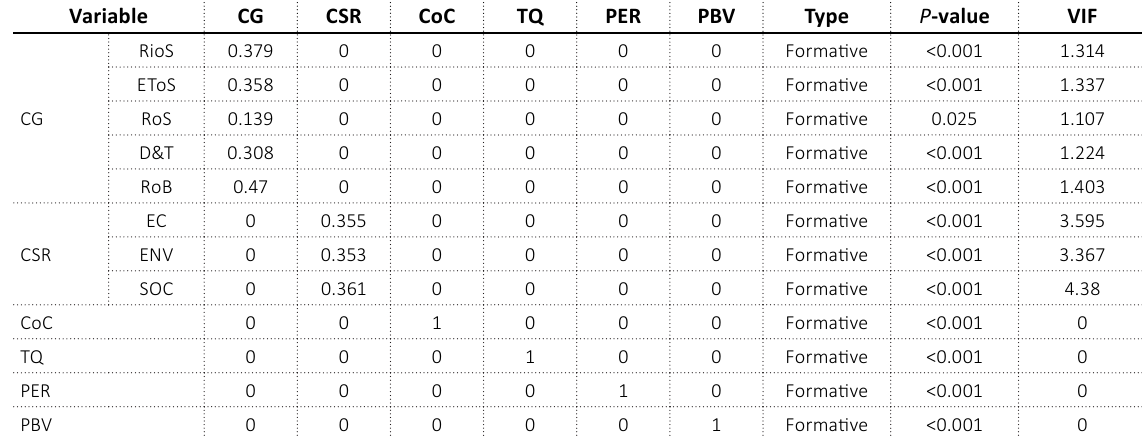
Table 3. Indicator measurement model test results